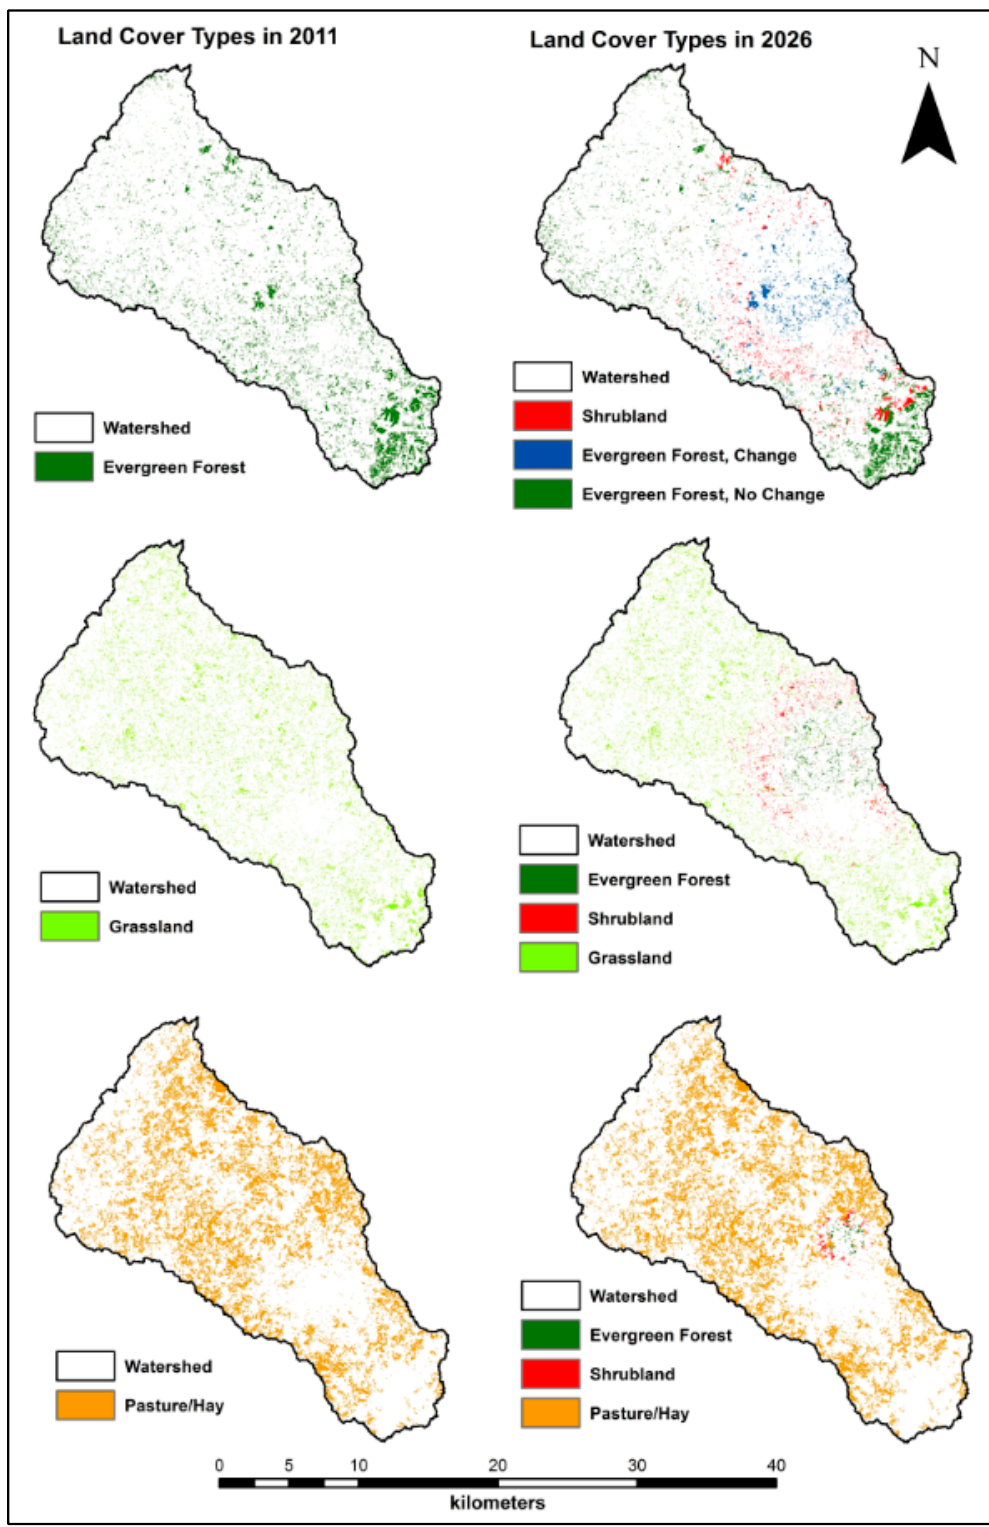
Figure 6. Transition of pixels to evergreen forest and shrubland over space and time under the High Demand scenario.